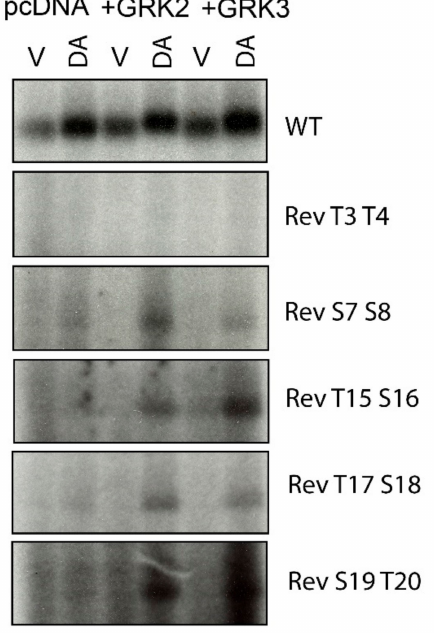
Figure 3. Overexpression of GRK2 or GRK3 can enhance dopamine-induced phosphorylation of specific D1R residues. In situ phosphorylation assays were performed as described in Section 4. Cells were transfected with either empty vector, GRK2, or GRK3 along with the D1R WT and site-specific reverse mutants of the C-terminus. Cells were treated with either vehicle (labeled “V”) or 10 µ M dopamine (labeled “DA”) for 15 min prior to lysis, immunoprecipitation, resolution by SDS-PAGE, and autoradiography. Equal amounts of D1R protein, as quantified by radioligand binding, were loaded into each lane of the gel. Representative experiments are shown, which were performed at least twice with similar results. Numbering scheme for the site-specific reverse (Rev) mutants are shown in Figure